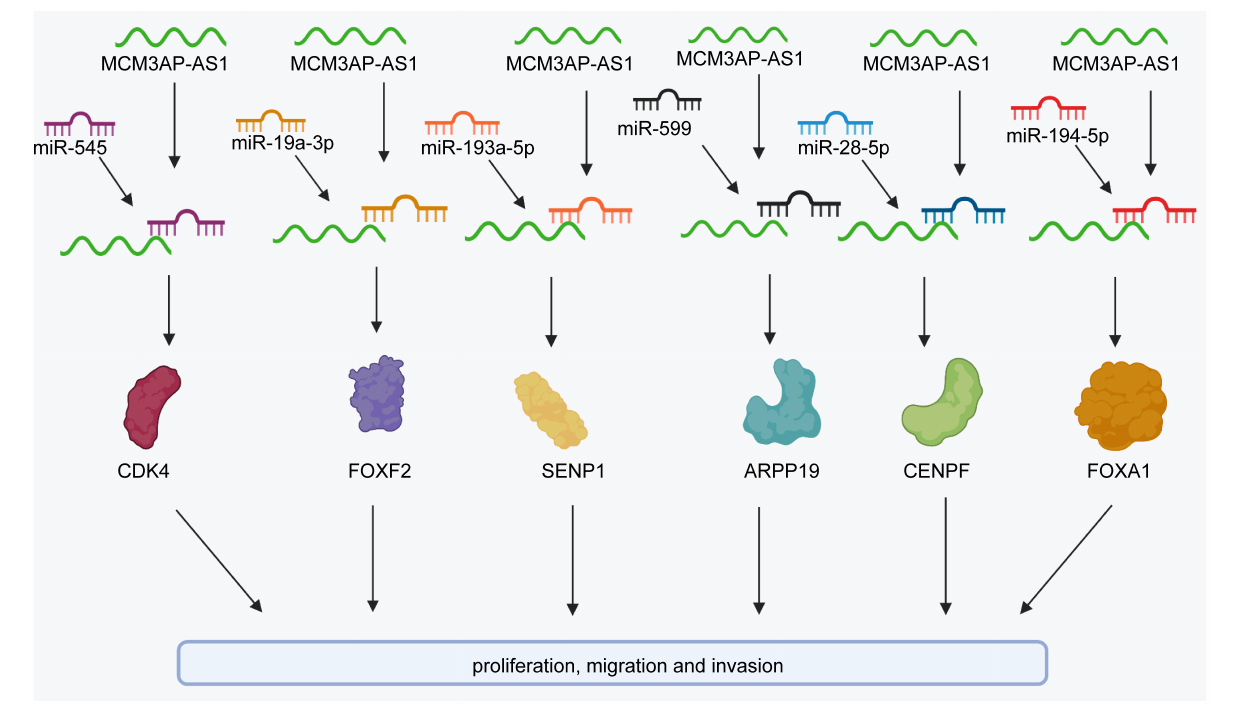
FIGURE 2 | The regulatory molecular mechanisms of the lncRNA MCM3AP-AS1 in CRC, breast cancer, and liver cancer. MCM3AP-AS1 facilitates the expression of SENP1 to attenuate cell proliferation and colony formation by sponging miR-193a-5p in CRC. MCM3AP-AS1 promotes the expression of FOXF2 to inhibit cell proliferation by sponging miR-19a-3p in CRC. It also promotes the cell cycle by activating the miR-545/CDK4 pathway. MCM3AP-AS1 inhibits ARPP19 levels by sponging miR-599 in colorectal